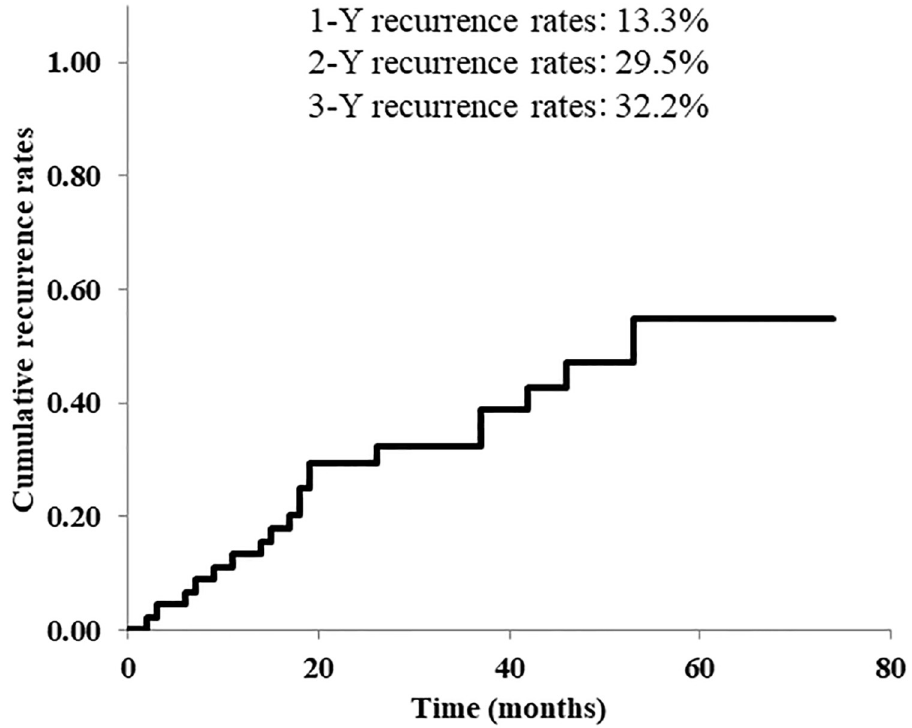
Fig 1. Cumulative recurrence rates of esophageal varices (EV) after endoscopic treatment (ET). During a median follow-up period of 30 months, recurrences of EV post-ET that required additional treatment occurred in 19 patients (42.2%), including seven patients with ruptured EV. After ET, the cumulative EV recurrence rates were 13.3% at 1 year, 29.5% at 2 years, and 32.2% at 3 years.